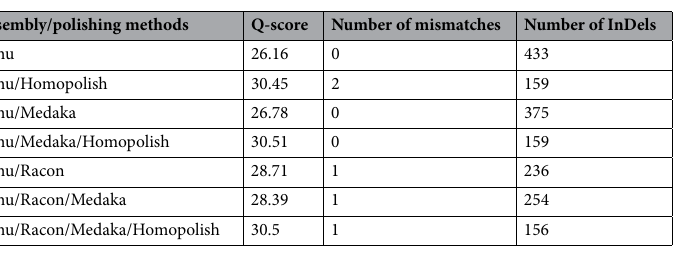
Table 2. Assembly and Polishing results using Illumina-sequenced genome (MN702446).